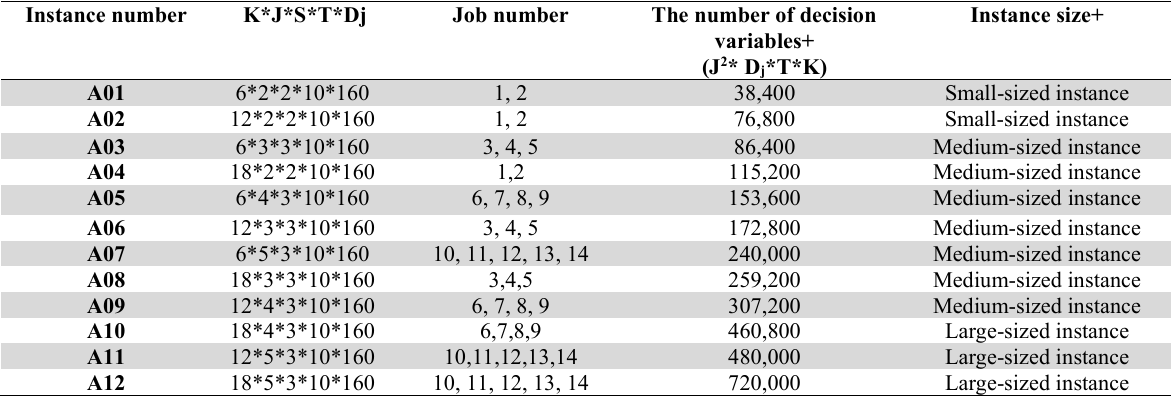
Configuration of testing